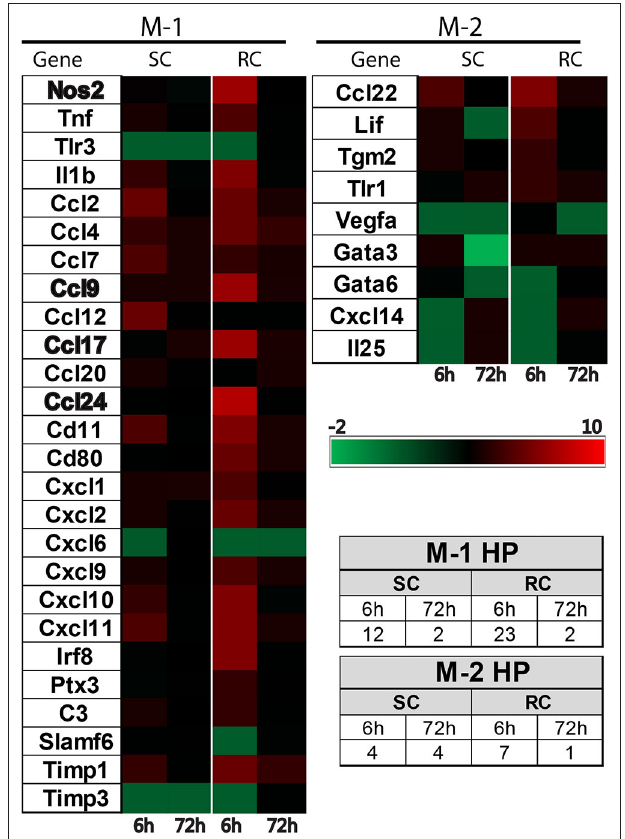
FIGURE 5 | Heat map showing inflammatory gene profiling of the ipsilateral hippocampus following concussive brain injury. Custom designed qRT-PCR mini-array identified genes that are upregulated (Red, ≥ 1.5 fold positive change compared to sham group) or downregulated (Green, ≥ 1 fold negative change compared to sham group). Left panel heat map shows altered M-1 markers and right panel shows M-2 markers that were changed. Names of the genes expressed more than 6 fold are identified in bold. Table insert shows the total number of genes that are changed under each condition. SC: single concussion, RC: repeated concussion, HP: